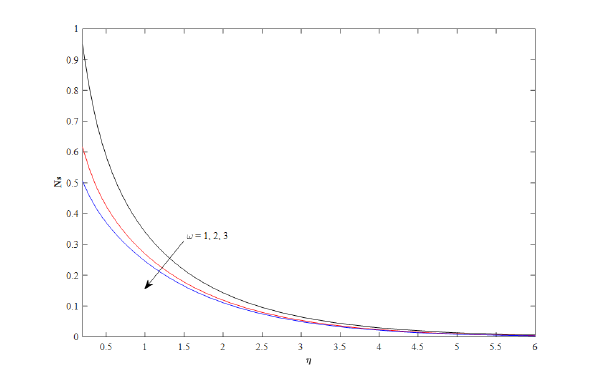
Fig. 5 Entropy generation number with varying ω when M = 1 , Q = 1 , Br = 1 , X = 2 , Pr = 2 , S = 0 . 01 , K = 0 . 95 .